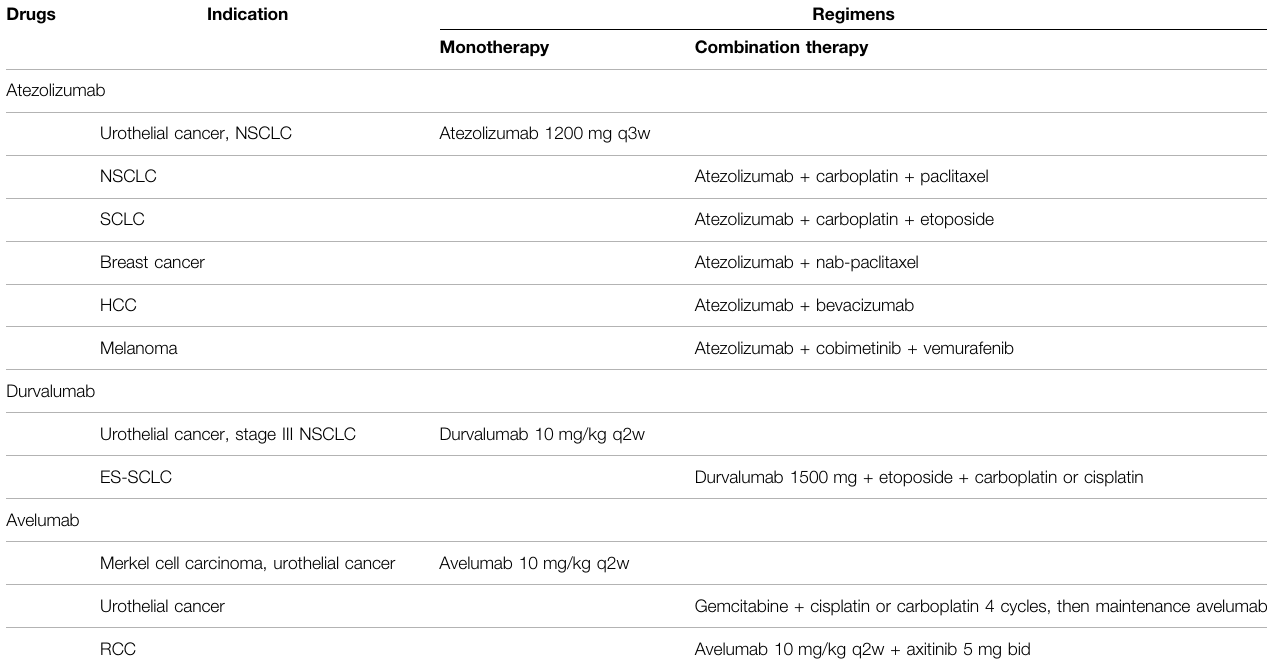
TABLE 2 | Clinical use of anti-PD-L1 antibodies.